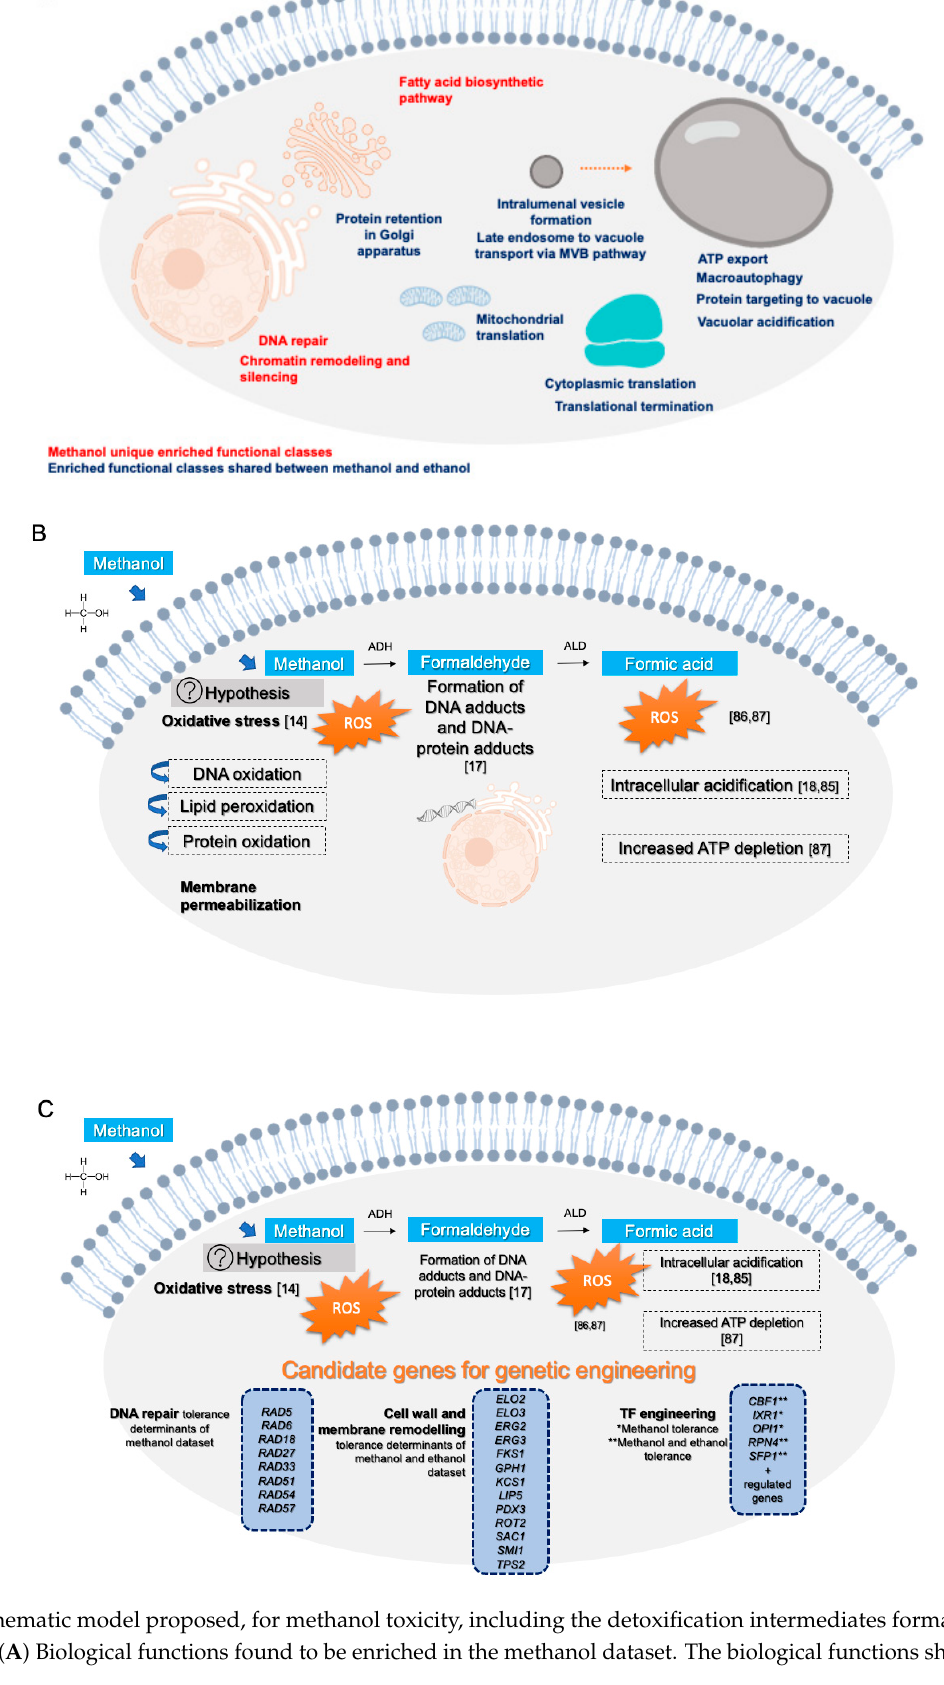
Figure 7. Schematic model proposed, for methanol toxicity, including the detoxification intermediates formaldehyde and formic acid. ( A ) Biological functions found to be enriched in the methanol dataset. The biological functions shared with